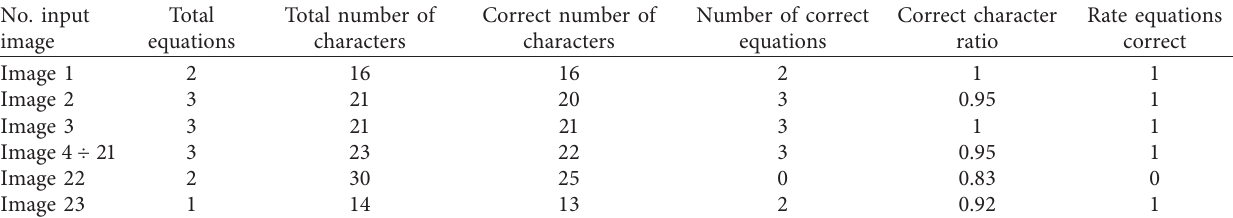
Table 4: Number of images of each letter to be prepared for training.